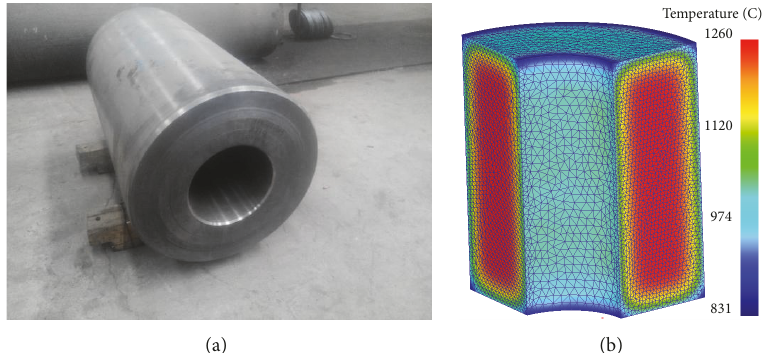
Figure 16: Experimental billet (a); billet temperature distribution before extrusion (b).